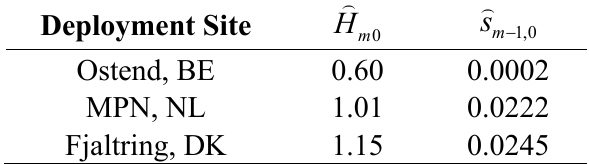
Table 8. Sea state averaged wave height and wave steepness for different test